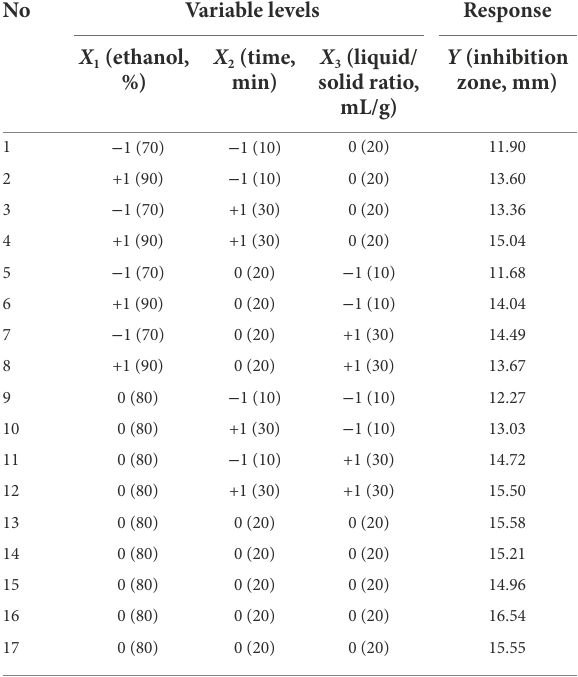
TABLE 1 Box–Behnken experimental design with the independent